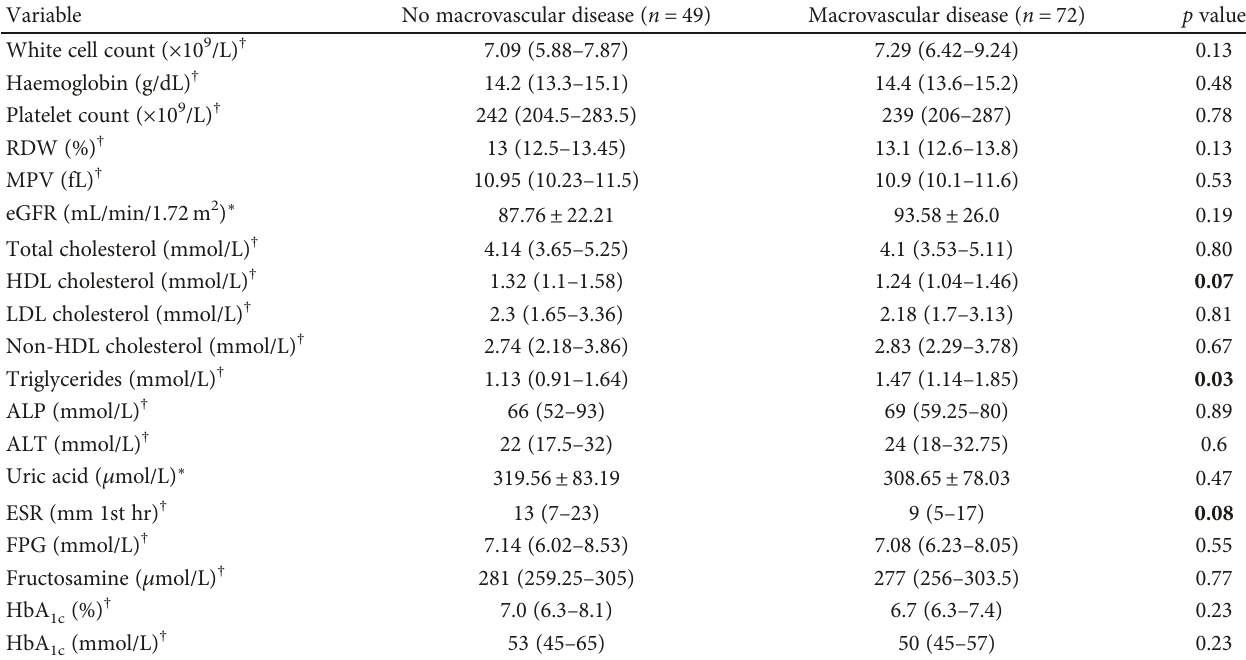
Table 4: Laboratory fi ndings of subjects with and without macrovascular disease.